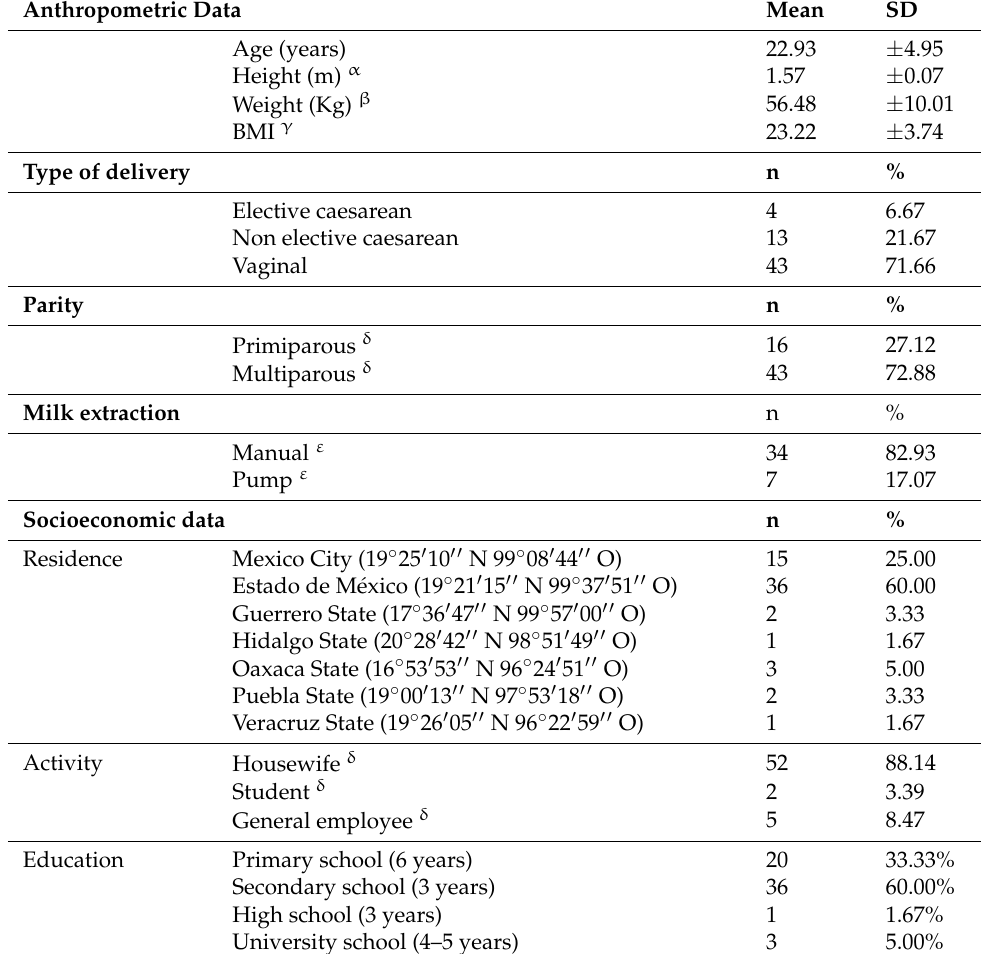
Table 1. Data for 60 participant mothers in the